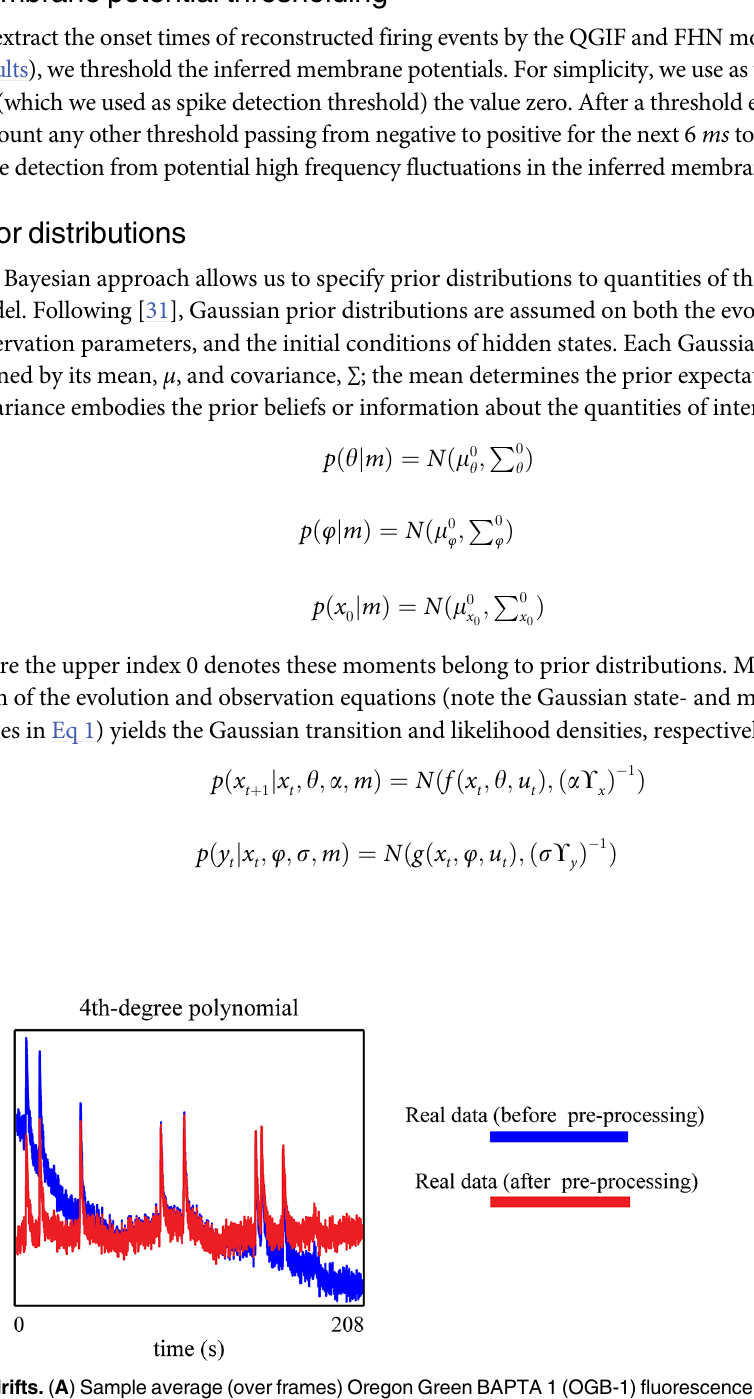
Fig 3. Field of view and low frequency temporal drifts. ( A ) Sample average (over frames) Oregon Green BAPTA 1 (OGB-1) fluorescence image of a neuronal population from the CA3 area of a hippocampal slice. ( B ) An in vitro OGB-1 fluorescence trace before (blue line) and after (red line) removal of its slowly varying components, by using the fourth degree polynomial detrending